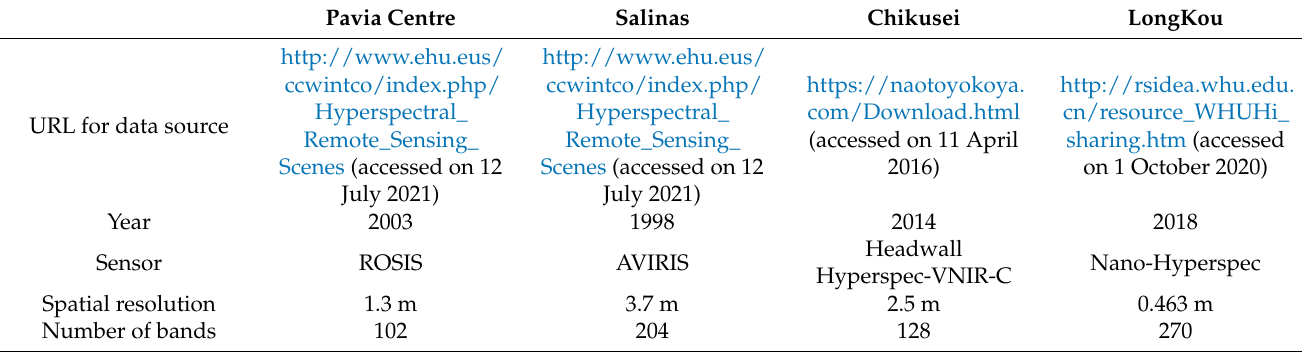
Table 1. Details of four real